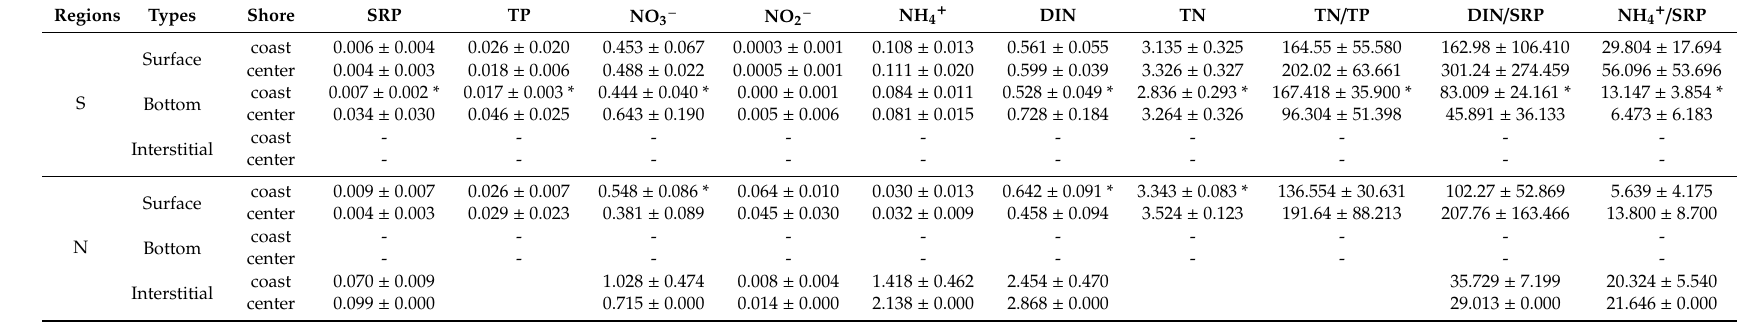
Table 1b. Di ff erences in nutrient concentration among the sampling stations at the coast and